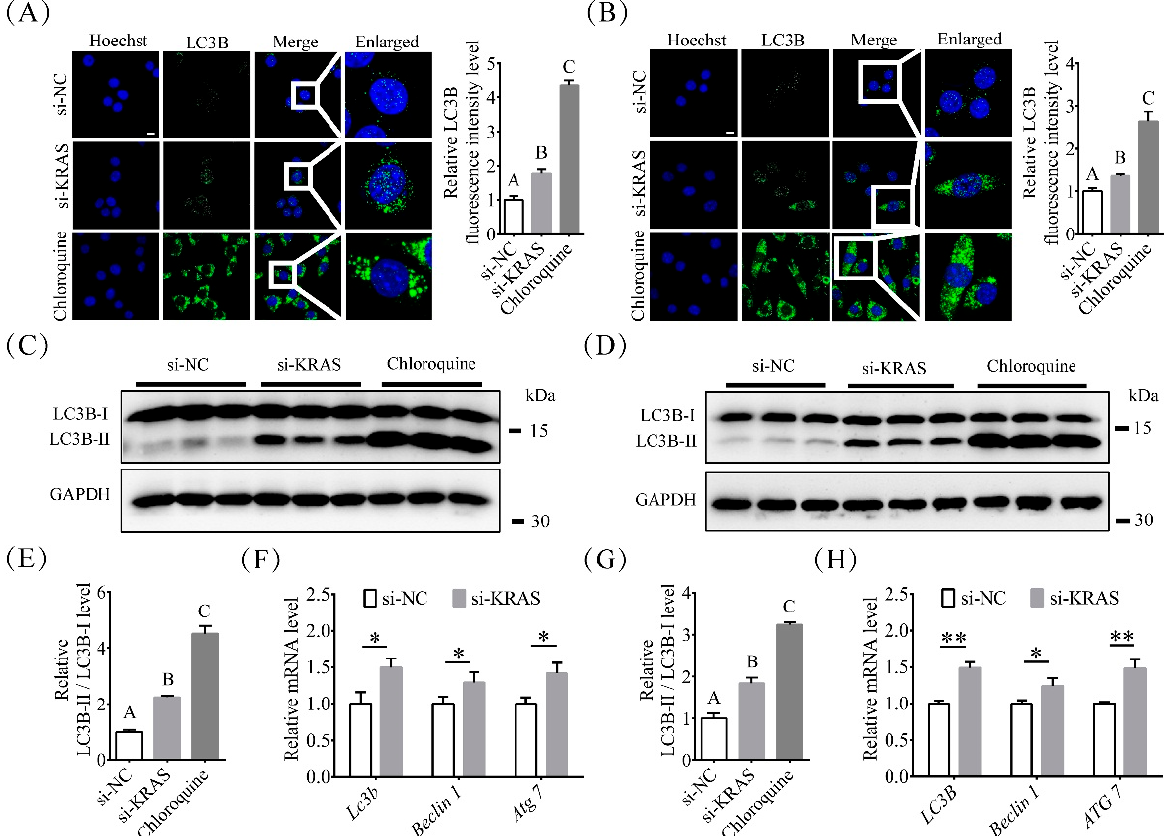
Figure 4. Effects of KRAS on autophagy in 3T3-L1 and C2C12 cells. ( A , B ) Representative immunofluorescence images and relative fluorescence intensity levels of microtubule-associated protein 1 light chain-3B (LC3B) in 3T3-L1 and C2C12 cells. Scale bar = 10 µ m. Significant differences are represented with different capital letters ( p < 0.01). ( C , E ) LC3B protein levels detected by Western blot analysis in 3T3-L1 cells. Significant differences are represented with different capital letters ( p < 0.01). ( F ) mRNA expression of Lc3b , Beclin1 , and autophagy related 7 ( Atg7) in 3T3-L1 cells with or without KRAS inhibition. Significant differences are represented with * ( p < 0.05). ( D , G ) LC3B protein levels detected by Western blot analysis in C2C12 cells. Significant differences are represented with different capital letters ( p < 0.01). ( H ) mRNA expression of Lc3b , Beclin1 , and Atg7 in C2C12 cells with or without KRAS inhibition. Significant differences are represented with * ( p < 0.05) and ** ( p < 0.01).